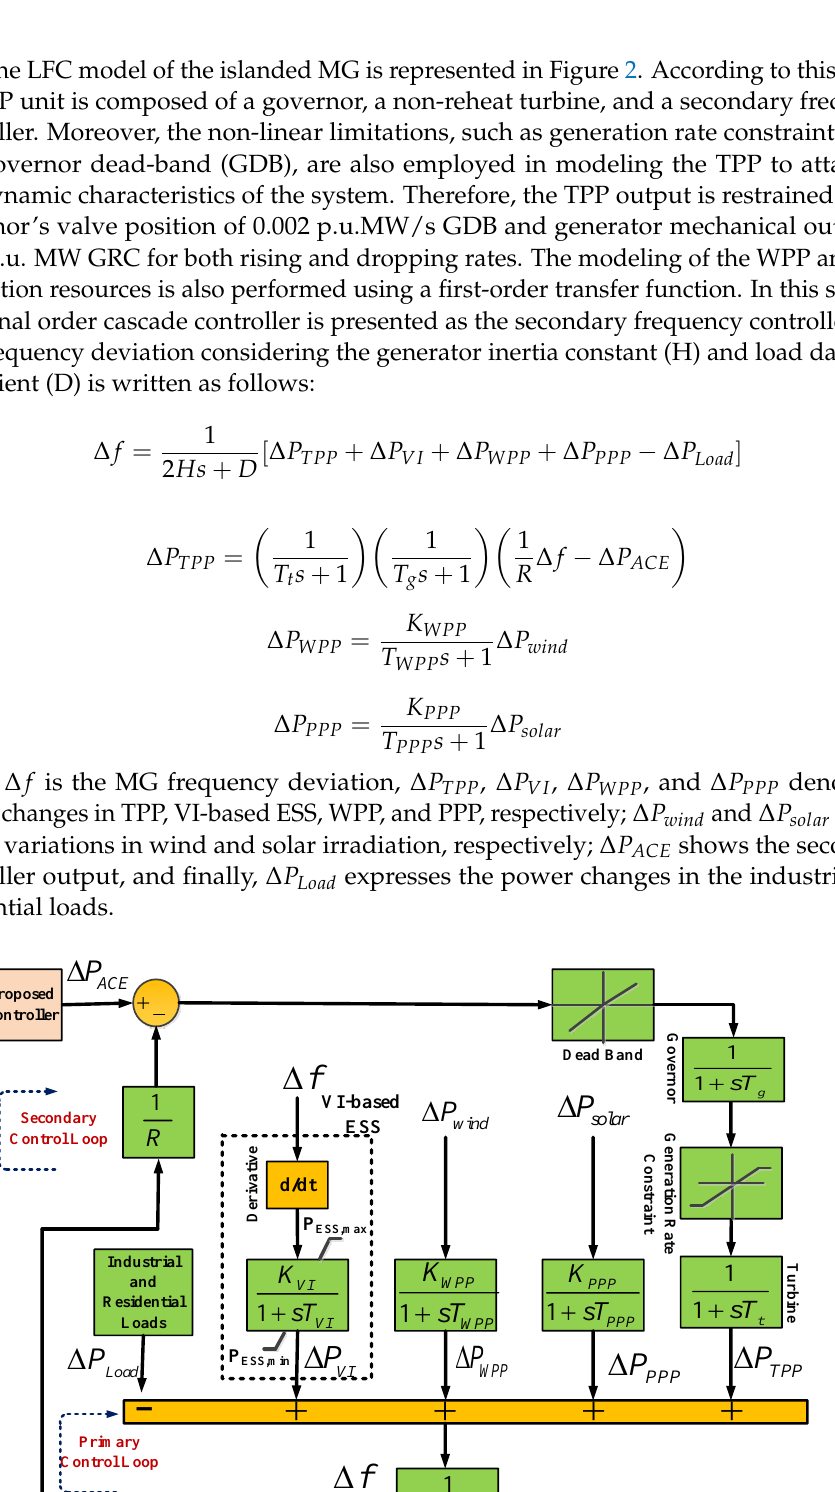
Figure 2. Diagram block of the islanded MG system.